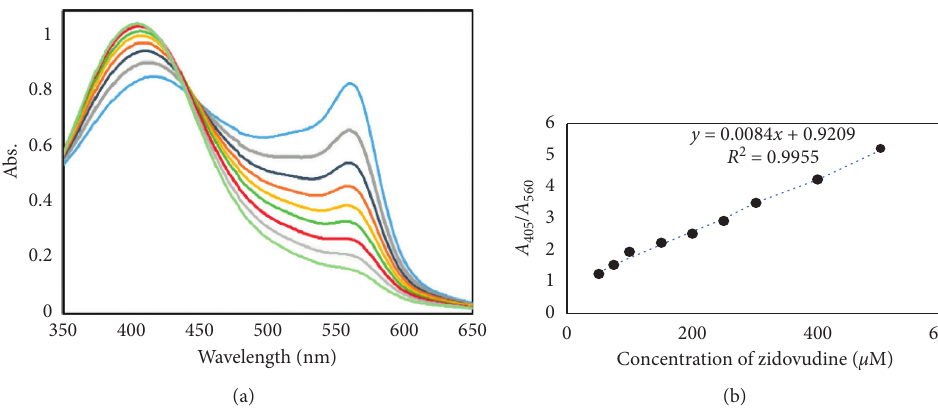
Figure 8: Absorbance peaks and calibration curve for AgNPs in the presence of different concentrations of zidovudine. Table 1: Determination of zidovudine in the real sample using AgNPs.